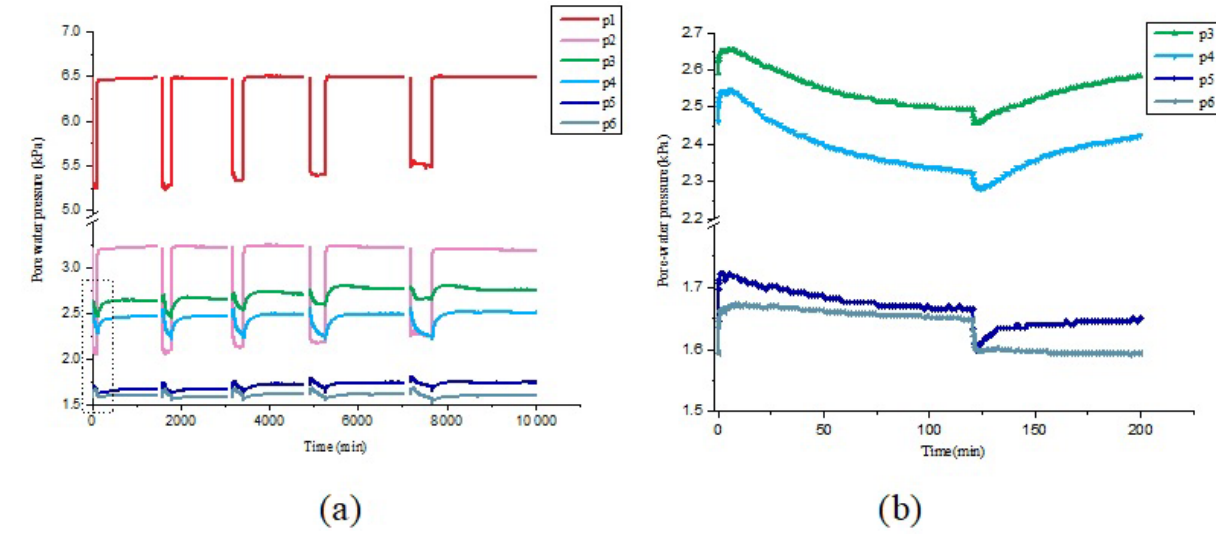
Figure 4. Pore water pressure of intermittent pumping. (a) Change of the pore water pressure. (b) Change of the pore water pressure in the first 20min.